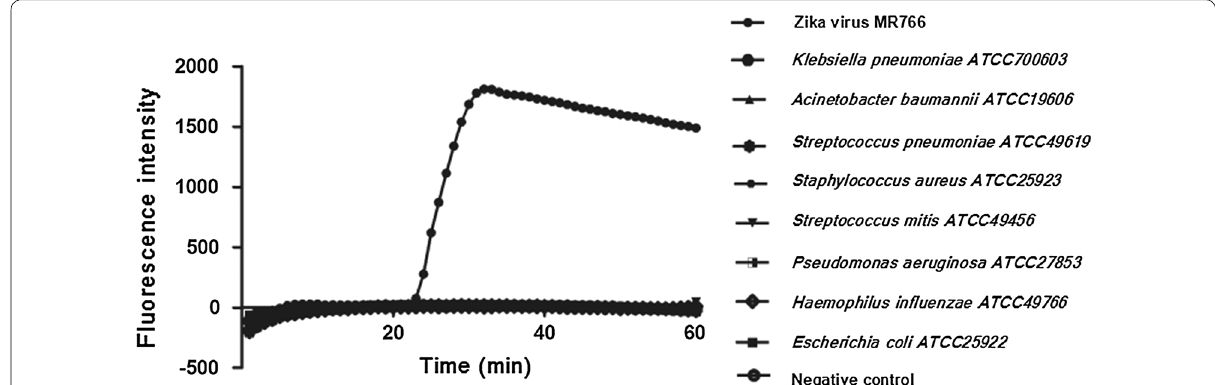
Fig. 6 Specificity of LAMP for the amplification of Zika virus